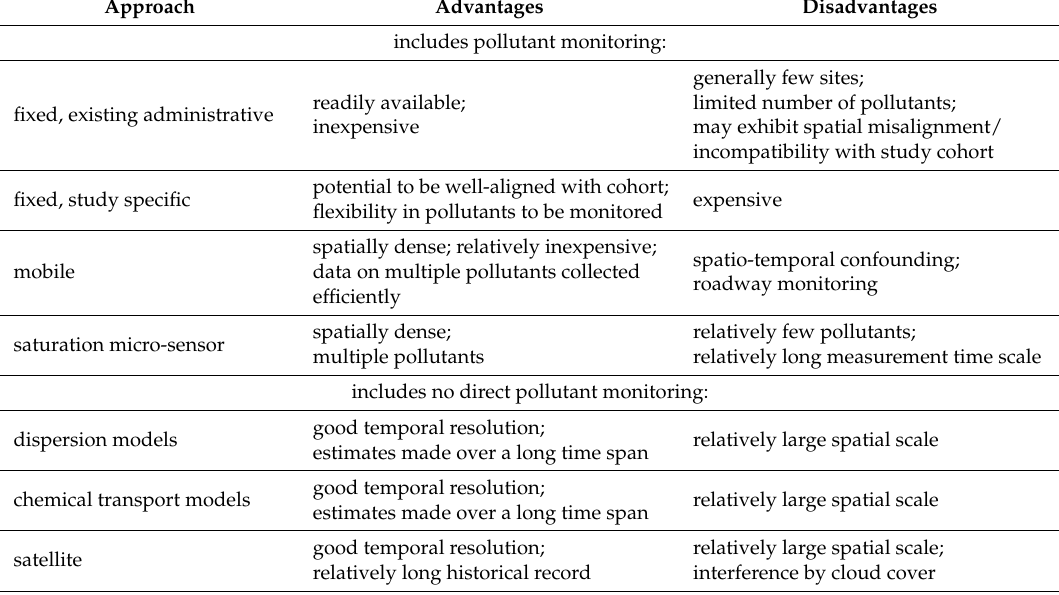
Table 4. Comparative advantages and disadvantages of potential sources of air pollution data for exposure prediction in cohort